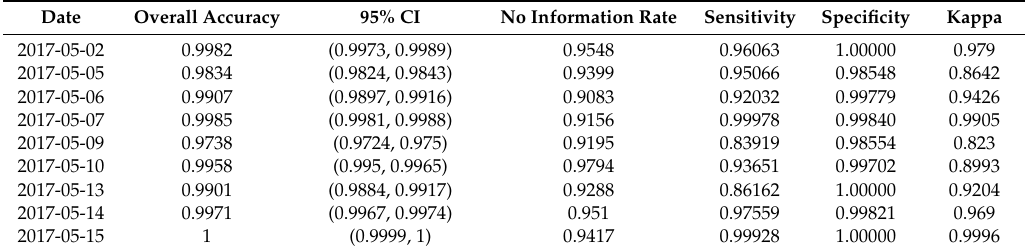
Figure 6. The frequency of pond duration beginning 6 May 2017, the cessation of daily precipitation exceeding 1-cm during the analysis period, indicates that the duration of ponds is bimodal with a large number of short duration ponds and a second, small peak of long-lasting ponds. Frequencies are shown on the y-axis as a base-10 log scale. Gaps in the data occurred because daily satellite coverage was not available, or cloud cover was too great. The jump in the frequency of long-lasting ponds includes a small number of permanent water features below the detection threshold of the Cropland Data Layer. Table 1. Accuracy statistics of classifier per date at the start of May 2017. All data were trained on 10-fold cross-validations benchmarked on kappa values. These statistics are from independent validations performed by reserving 10% of the training polygons, randomly sampled, which were not used in the training or prediction steps. All of our kappa values are greater than 0.8, suggesting that we had excellent performance in the